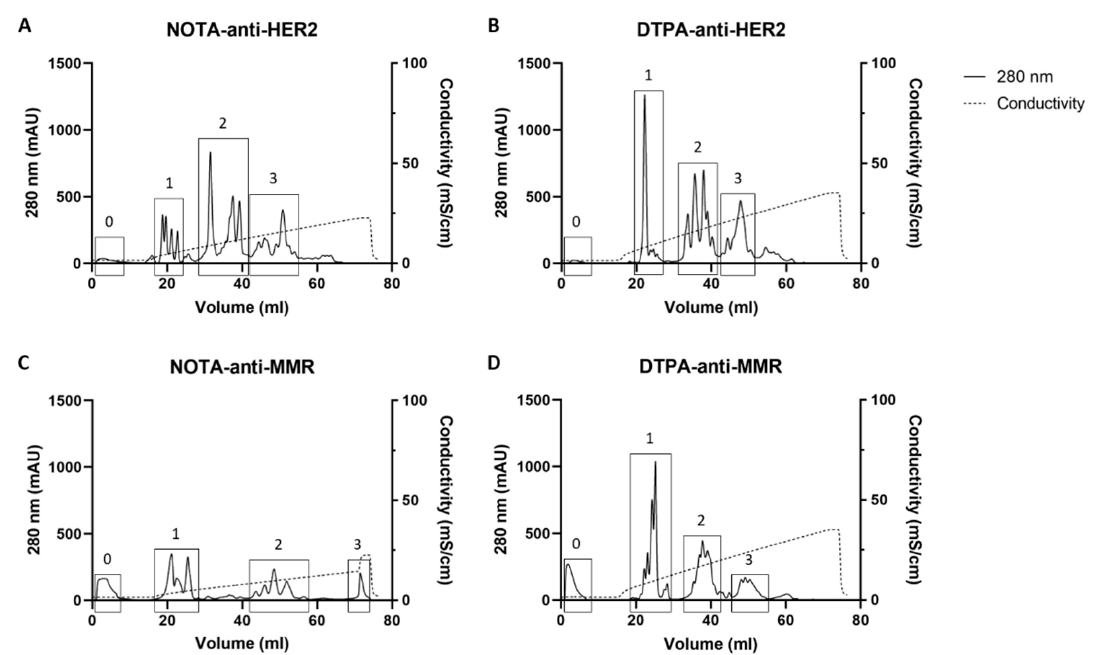
Figure 1. AEX purification profiles of ( A ) NOTA-anti-HER2, ( B ) DTPA-anti-HER2, ( C ) NOTA-anti-MMR, and ( D ) DTPA-anti-MMR. Clusters of peaks containing (chelator) 1 -sdAb (fraction 1), (chelator) 2 -sdAb (fraction 2), or (chelator) 3 -sdAb (fraction 3) are framed denoted with 1, 2, and 3, respectively. Frames denoted with 0 correspond to unconjugated sdAb. The separation of fractions is achieved by an increasing salt gradient resulting in increasing conductivity. The clusters or fractions were defined by identification of each peak individually via MS.